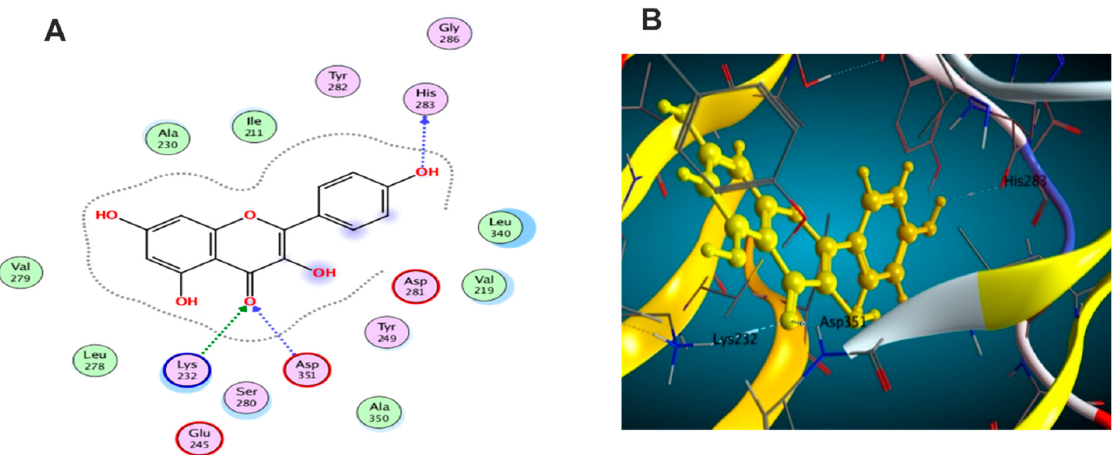
Figure 12. Docking results of compound 4 in the active pocket site of (TGF- β ) (6B8Y): ( A ) 2D interactions of compound 4 ( B ) 3D Docking pose of compound 4 .